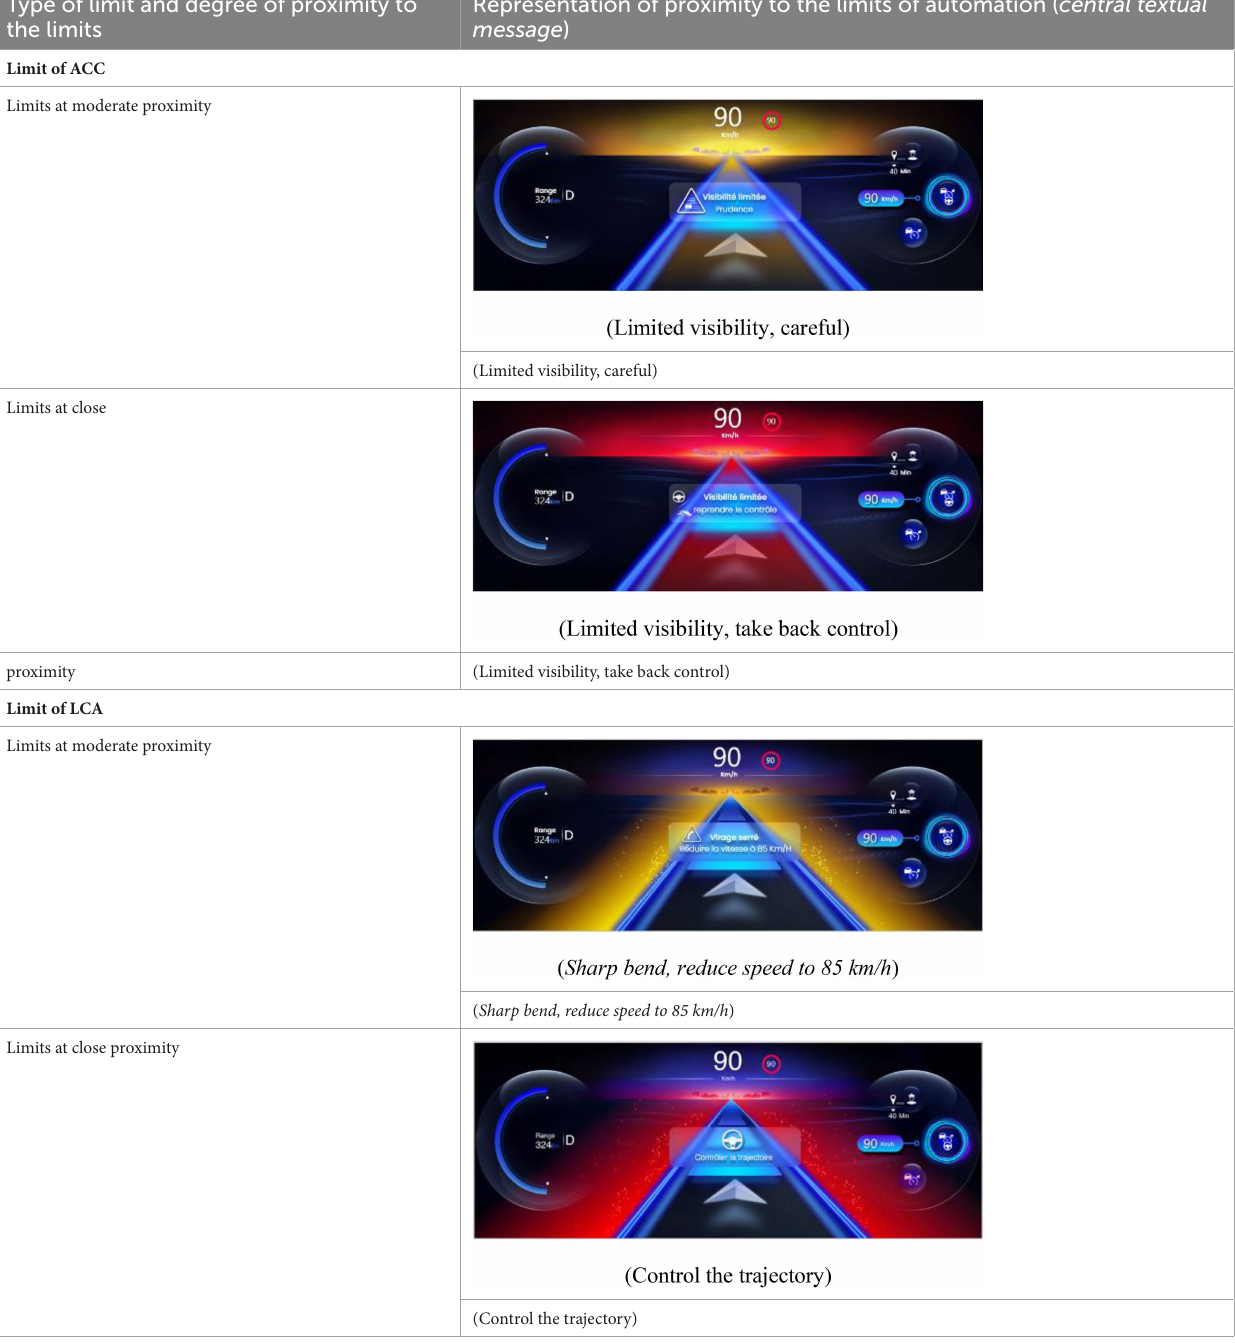
Representation of proximity to the limits of automation ( central textual message